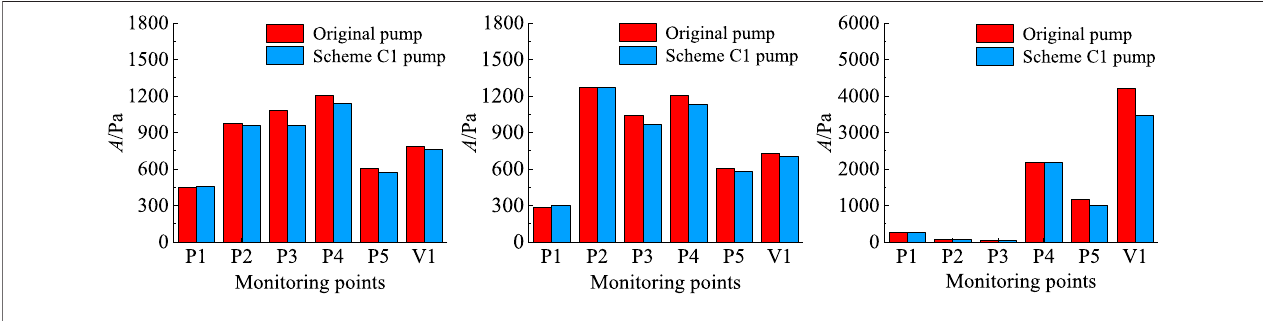
FIGURE15 | Amplitude of main frequency of